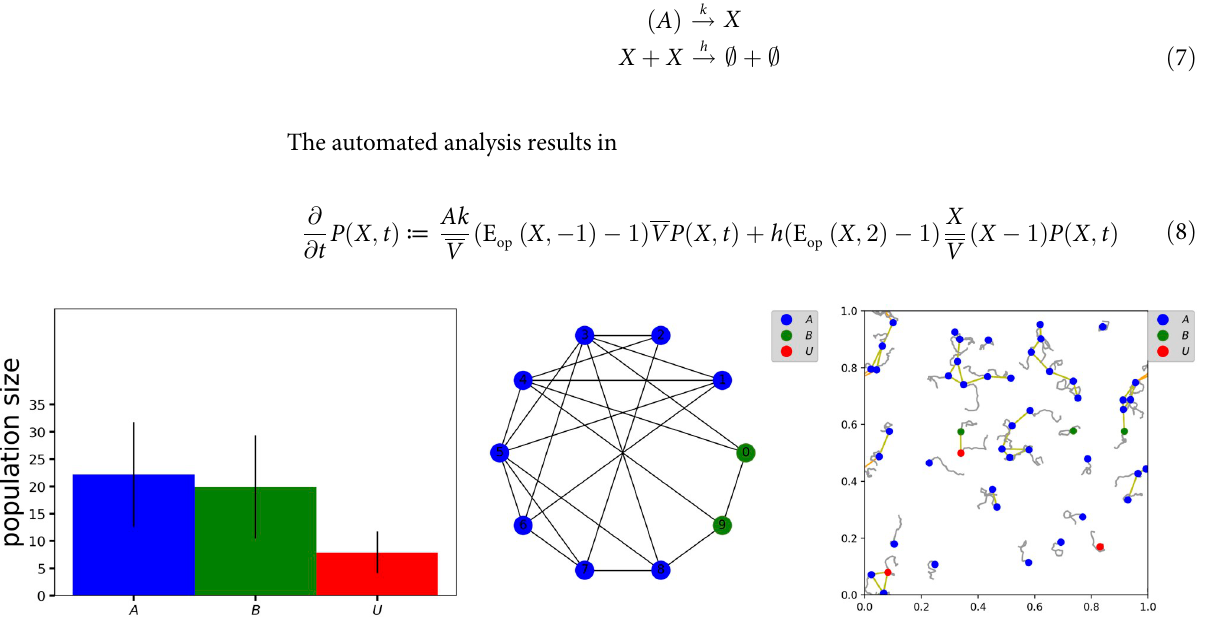
Fig 6. Numerical simulations of a nonlinear decision-making model. Numerical simulations of the honeybee swarming model [2, 14] given various sources of noise. Left: finite-population noise effects during symmetry-breaking in a well-mixed model (cf. [14] Movie S1) (parameters Δ = 0, μ = 3.0, s = 3.0, F Ut (0) = 1.0, system size = 50, time = 10, runs = 10). Centre: finite-population and spatial noise effects due to embedding the model in a random graph. Right: finite-population and spatial noise effects due to embedding the model in a plane, with agents performing correlated random walks; traces indicate recent agent paths, links indicate current interaction events.